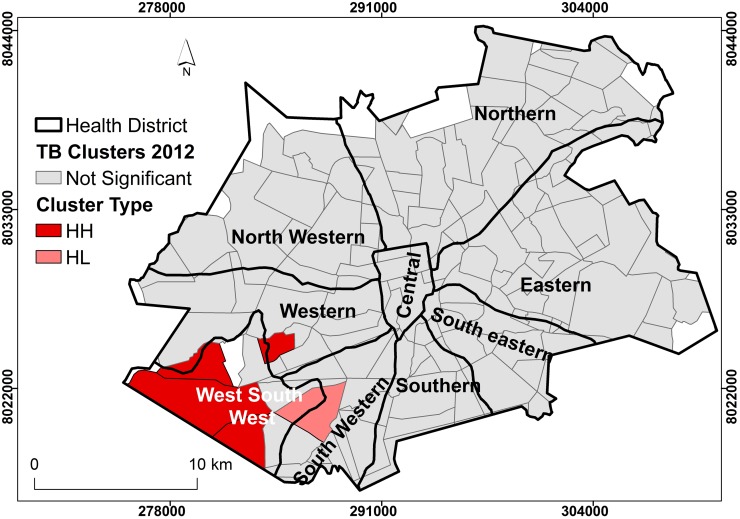
Clustering of TB cases by district, Harare City, 2012.Show the clustering of cases within district. Suburbs with deep shade represent increased occurrence of TB cases that are related to other cases within the same district, (clustering). Districts with clear colour show no clustering at all.